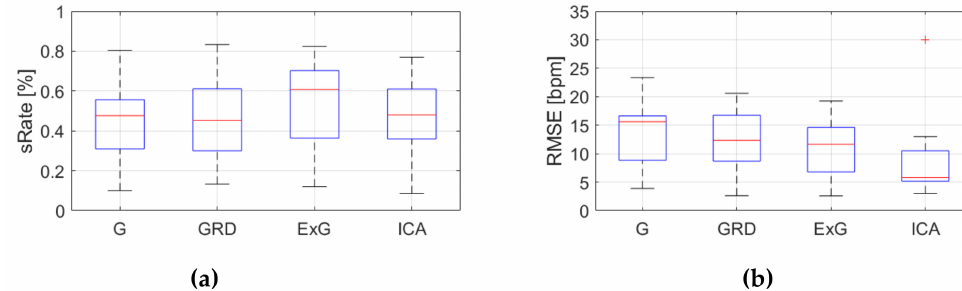
Figure 7. Comparison of signal extraction methods, algorithm No.2 (AR): ( a ) box plots for sRate ; ( b ) box plots for RMSE . Blue lines—IQR range, red line—median value.